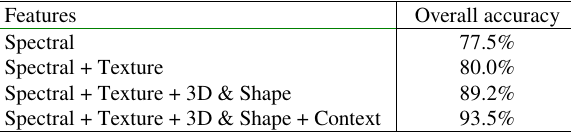
Table 1. Classification overall accuracy combining feature groups.